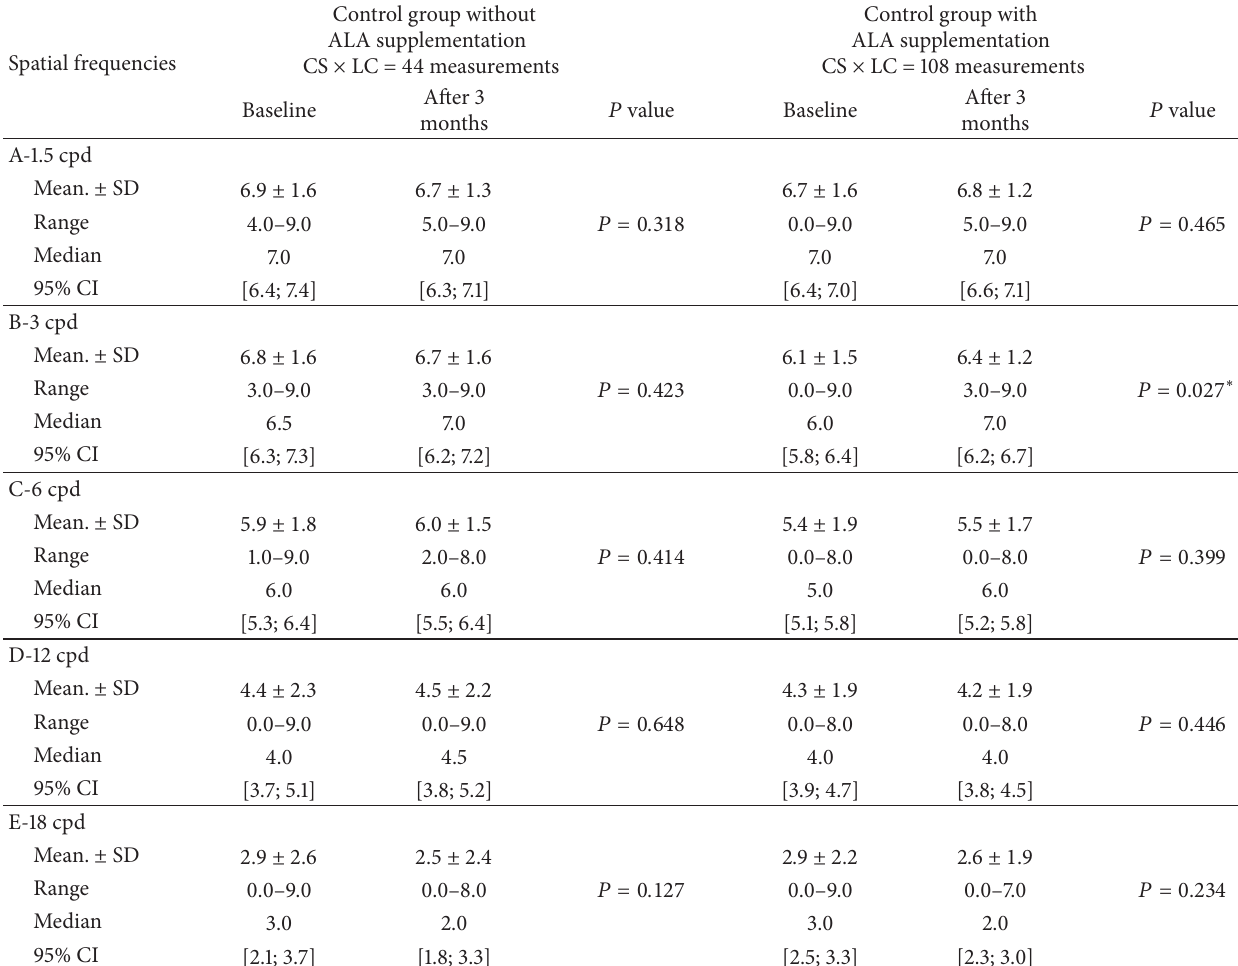
Table 4: Characteristics of contrast sensitivity examinations in the control group with and without ALA supplementation at baseline and after 3